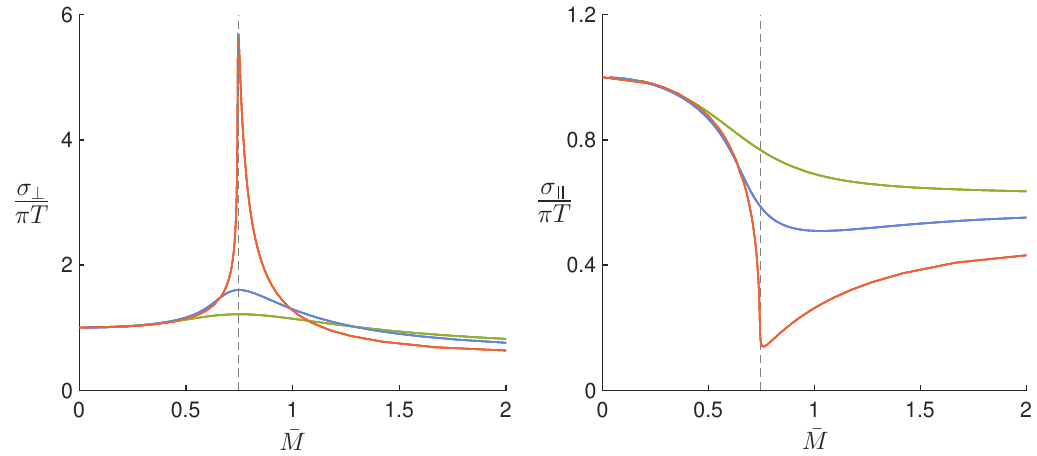
Figure 4. Longitudinal conductivities (cid:27) xx ; (cid:27) zz in function of the dimensionless quantum parameter (cid:22) M for temperatures (cid:22) T = 0 : 1 ; 0 : 05 ; 0 : 005 (from green to